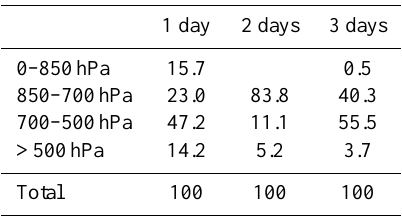
Table 2. Percentage contribution of each atmospheric layer to the air arriving on a low ozone day in Cairo at 1.5–5km on 26 July 2002 (Flight: MD20020726023), for 1-day, 2-day and 3-day FLEXPART backward